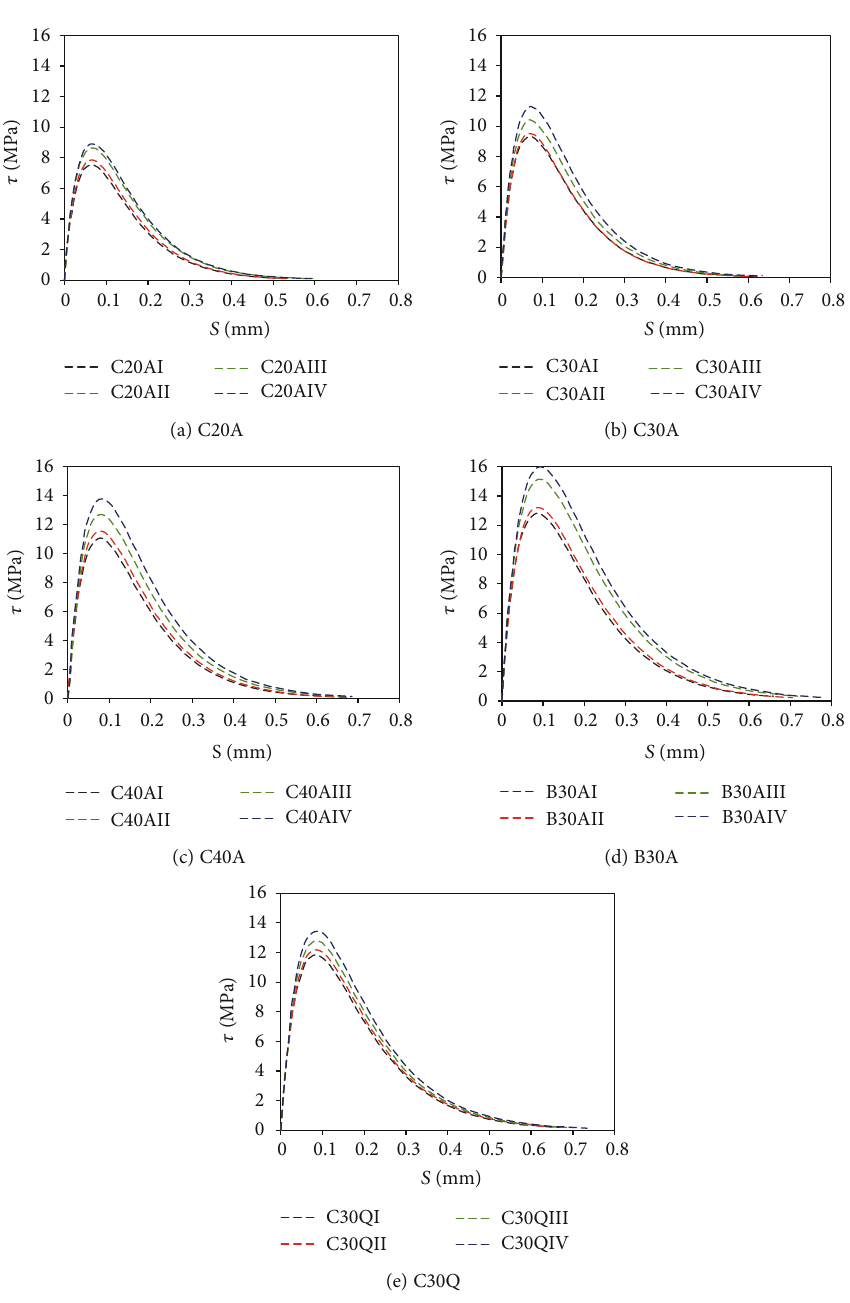
Figure 8: Bond-slip curves of the